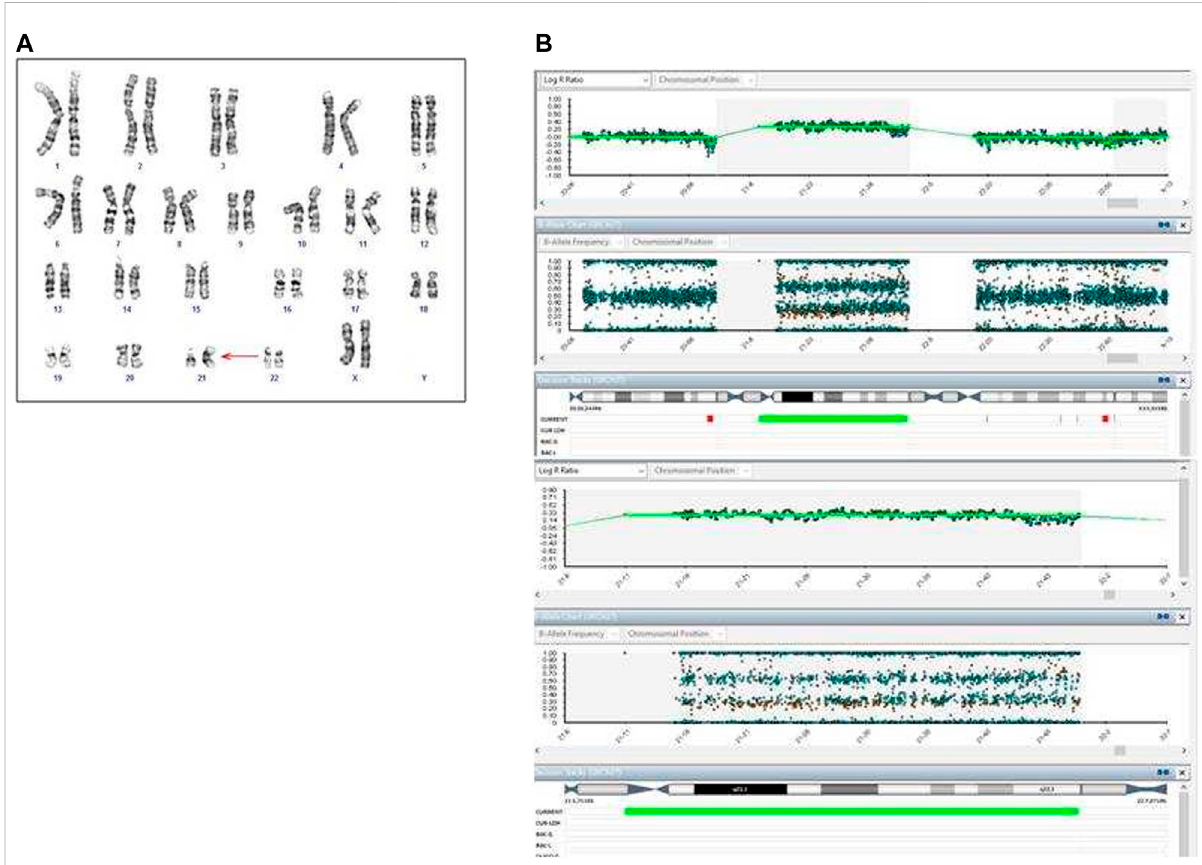
FIGURE 4 Cytogenetic and cytogenomic analyses on amniotic fl uid of Case 2. (A) GTG banding karyotype shows a complete T21; (B) SNP-array shows a complete T21. Log ratio > 0 indicates a copy number gain for chromosome